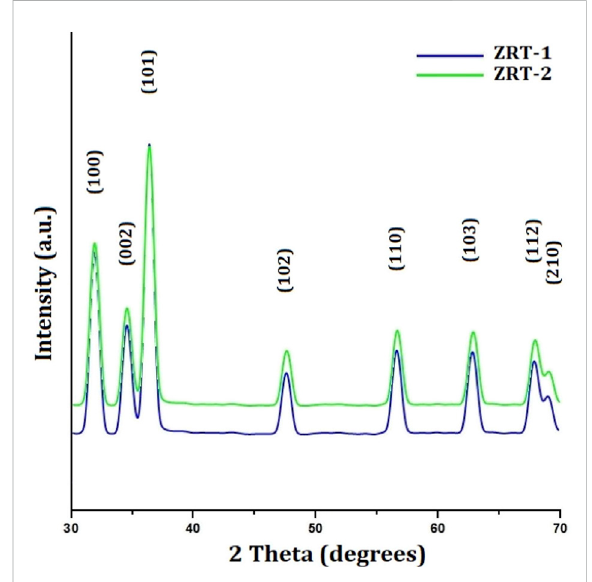
FIGURE 1 XRD characterization of ZRT samples prepared by varying reaction time of ion-carriers on the synthesis of zinc oxide nanoparticles: ZRT-1 and